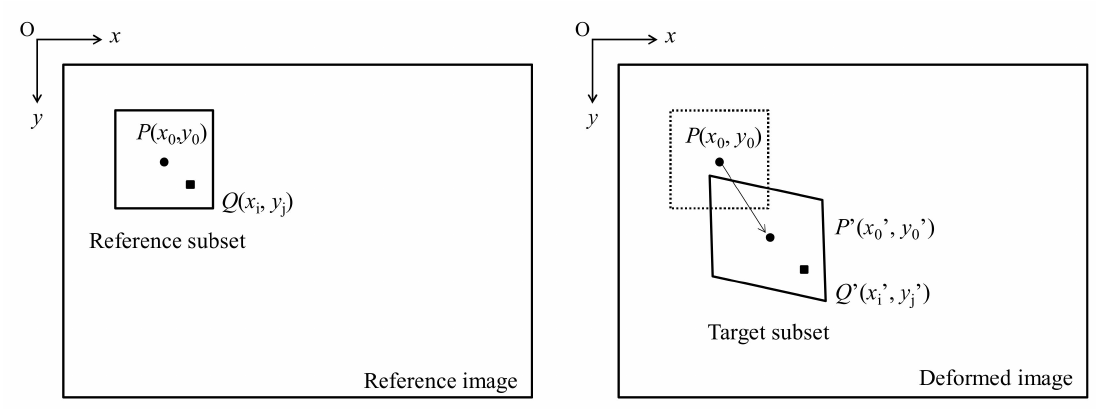
Figure 1. Reference subset before deformation and target after